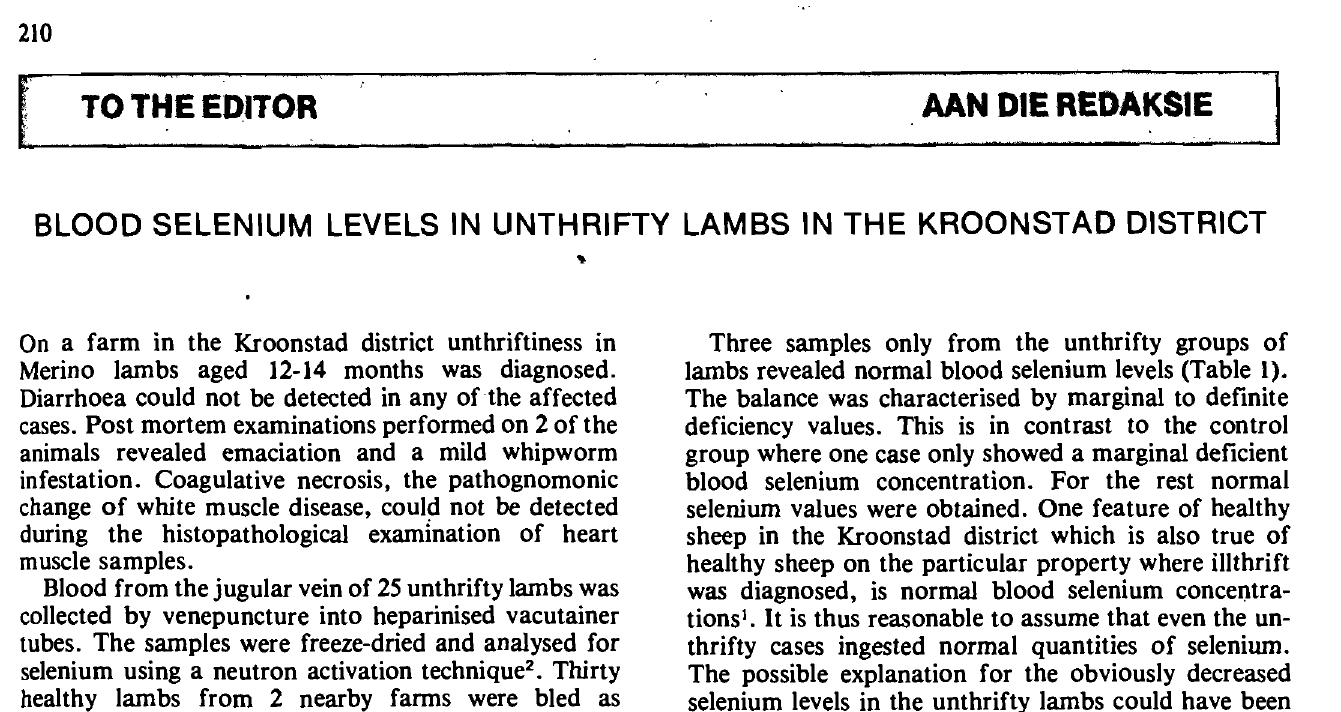
Table 1: BLOOD SELENIUM CONCENTRATIONS OF UNTHRIFTY AND HEALTHY CONTROL LAMBS IN THE KROONSTAD DISTRICT (ug/ml) - - Blood selenium Number of lambs in iAverage selenium levels" of concentration' Unthrifty